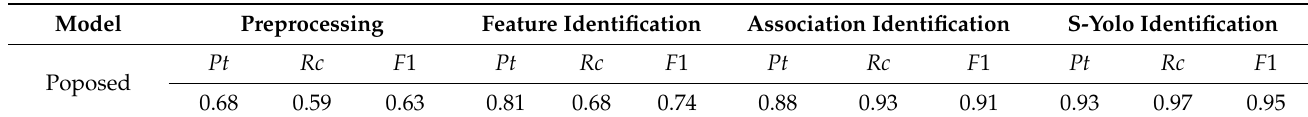
Table 2. Comparison of 20 groups of remote sensing data test results [ Pt , Rc , F 1]. No. Table 3. Performance comparison of calculation results of different discrimination steps of the design method in this paper.